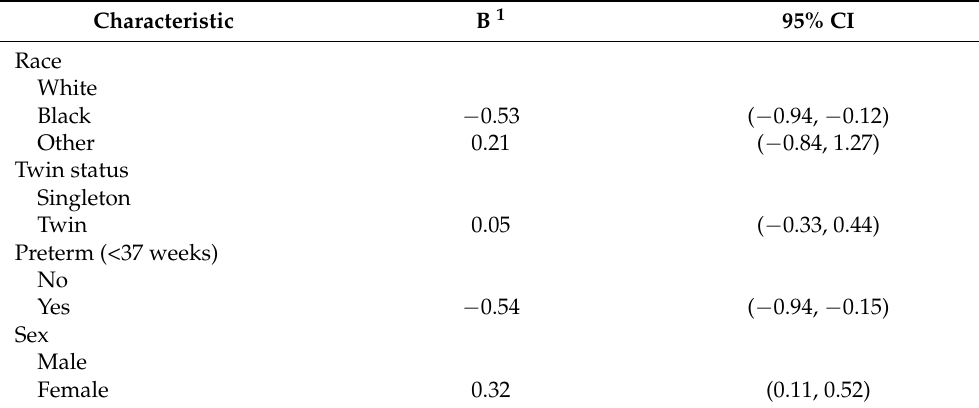
Table 3. Maternal, pregnancy and infant characteristics associated with cord blood serum ferritin: multivariable regression model.